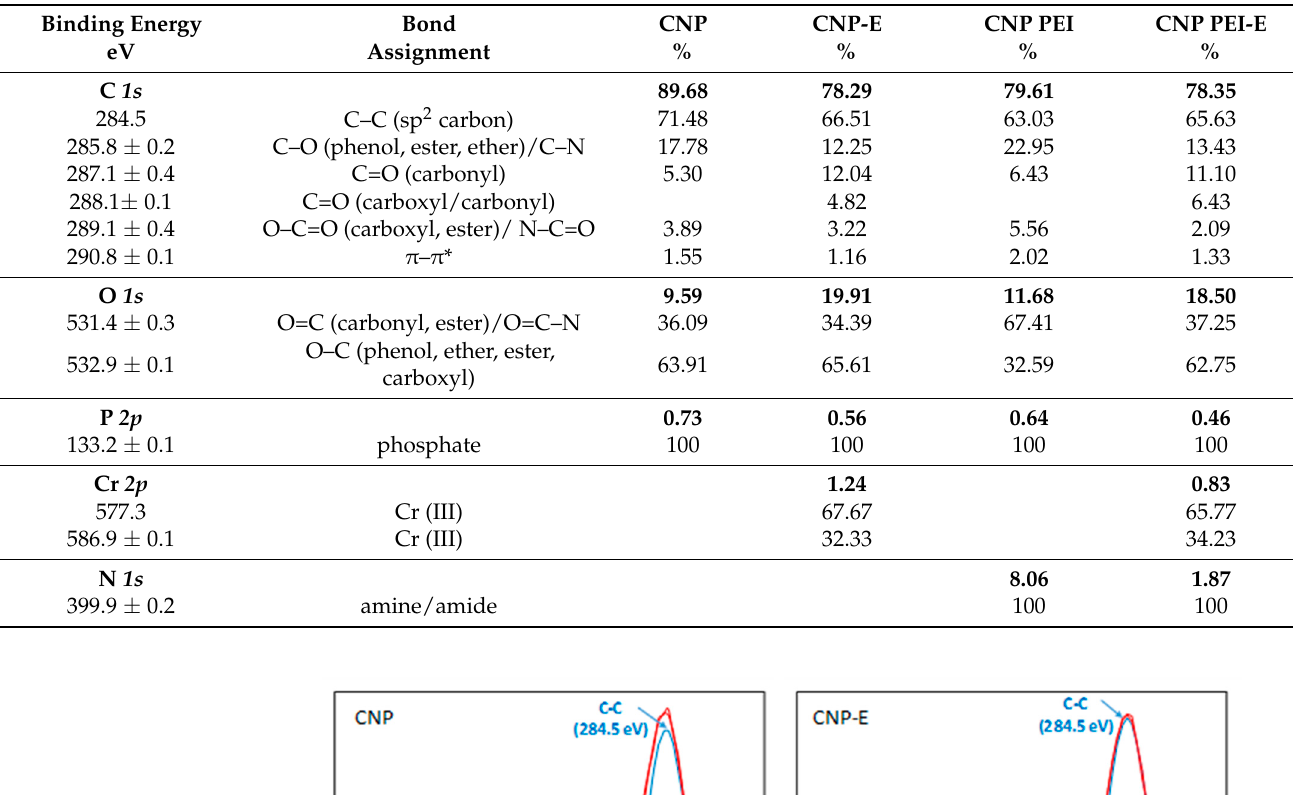
Table 2. Results of the deconvolution of the XPS spectra for C 1s , O 1s , P 2p , Cr 2p , and N 1s and the element content in atomic % (bold letters) for the initial and exhausted “E” CNP carbon with and without PEI.